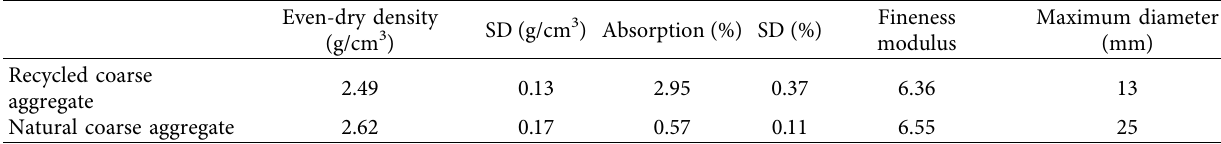
Table 1: Properties of the coarse aggregates.